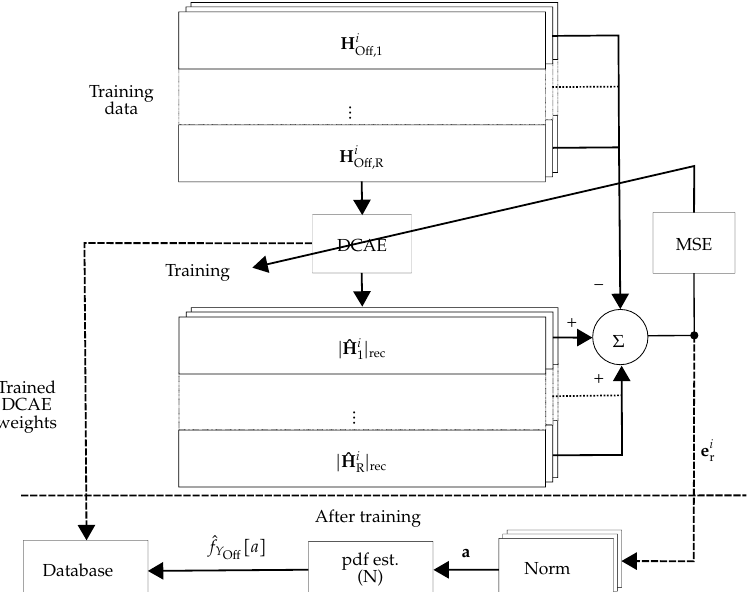
Figure 5. Schematic view of the offline phase of centralized processing: In the offline phase, DCAE is trained. Then, the pdf approximation of the anomaly score ( ˆ f Y network (DCAE * ) are stored in the